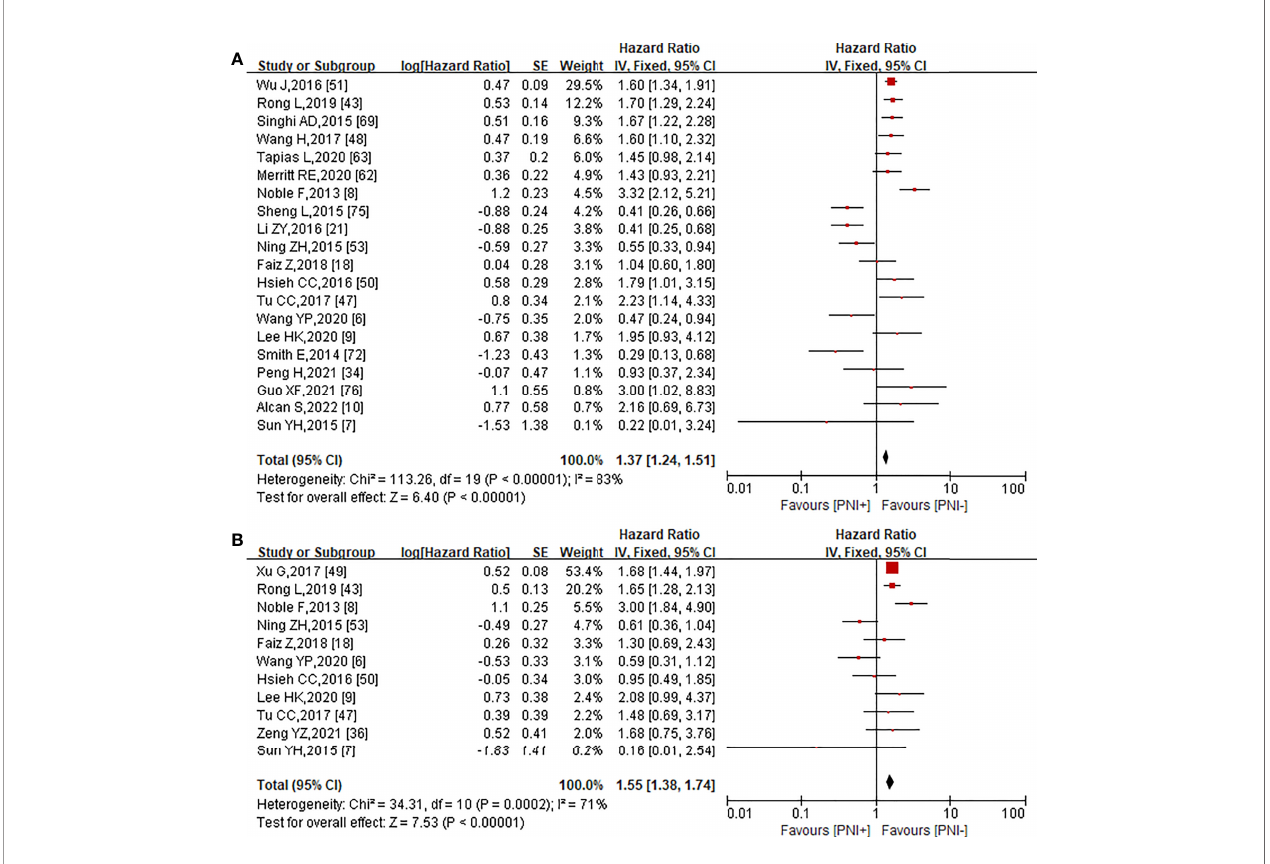
FIGURE 4 | Forest plot analysis for signi fi cant correlation between the presence of PNI and5-year OS (A) , 5-year DFS (B)